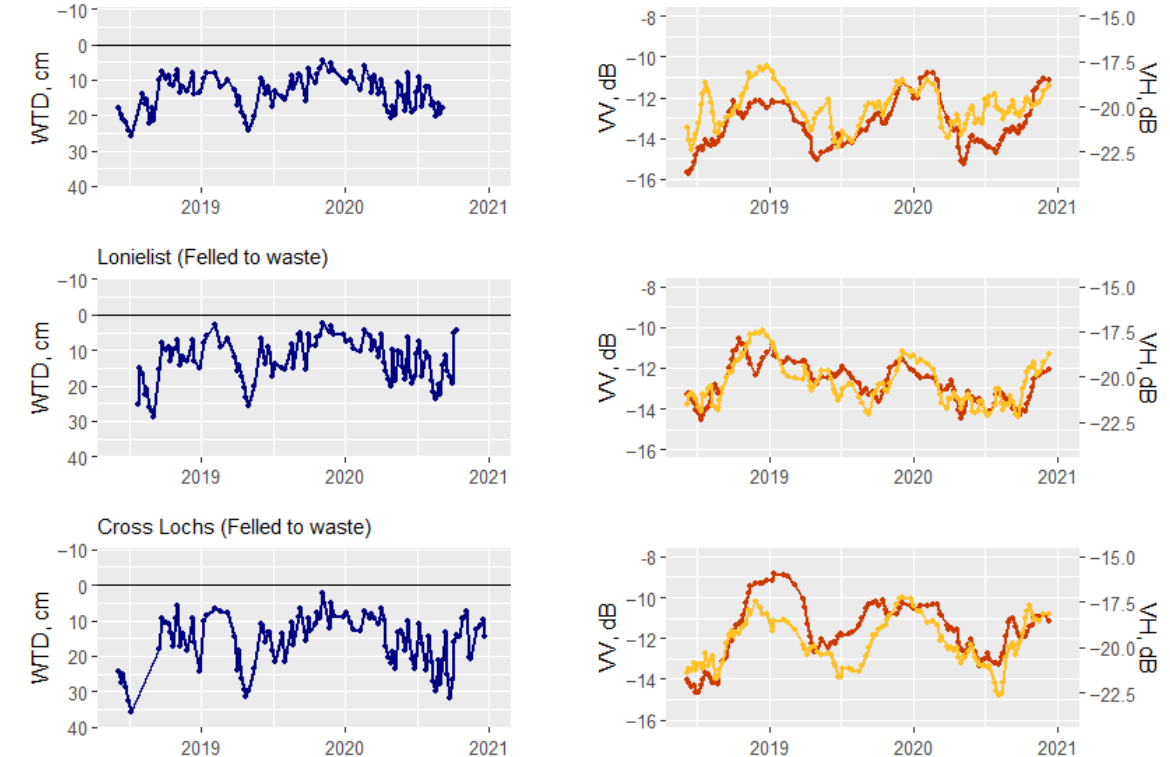
Figure 4. Observed water table depth ( left ) and Sentinel-1 (( right ); VV in red, VH in yellow) backscatter time series for peatland sites with simplistic restoration (felling to waste) applied. The black horizontal line indicates the ground surface.